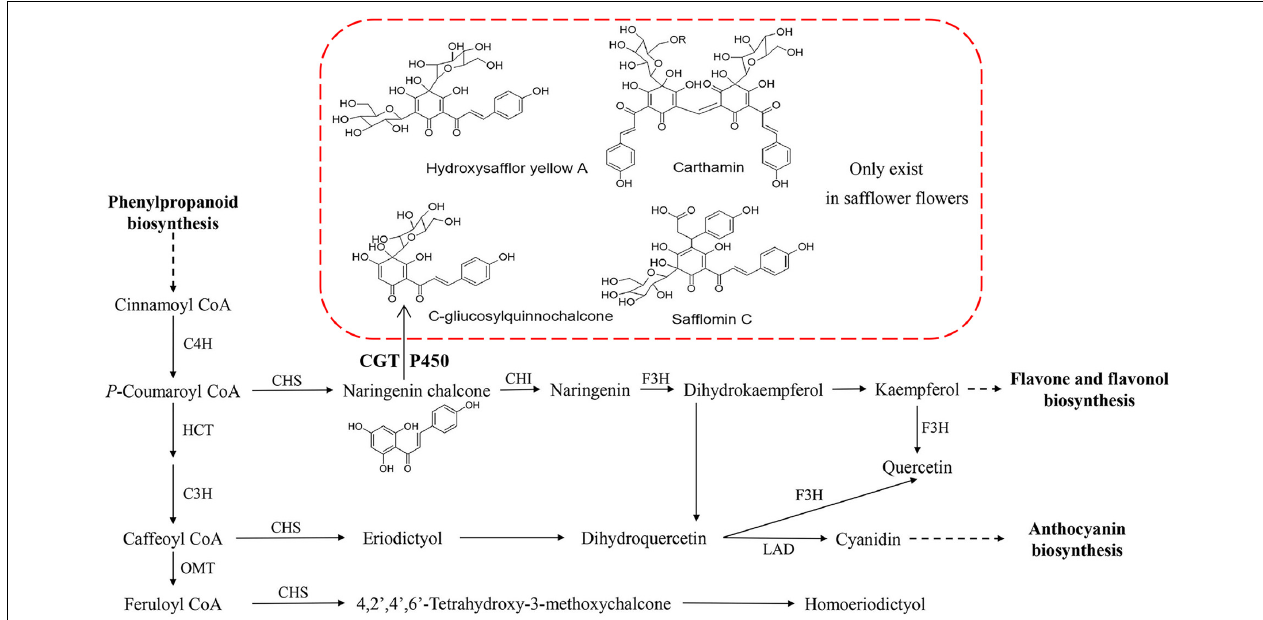
FIGURE 1 | Flavonoid biosynthesis pathway in safflower flower. In red frame, some quinochalcone C-glycosides and their derivatives only existed in safflower flowers. CGT and P450 might take part in biosynthesis of HSYA. C4H, cinnamate-4-hydroxylase; HCT, shikimate O-hydroxycinnamoyltransferase; C3H, cinnamate-3-hydroxylase; OMT, O-methyltransferase; CHI, Chalcone isomerise; CHS, Chalcone synthase; F3H, Flavanone 3-hydroxylase; HYSA, Hydroxysafflor yellow A; CGT, C-glycosyltransferase; P450, cytochrome P450.